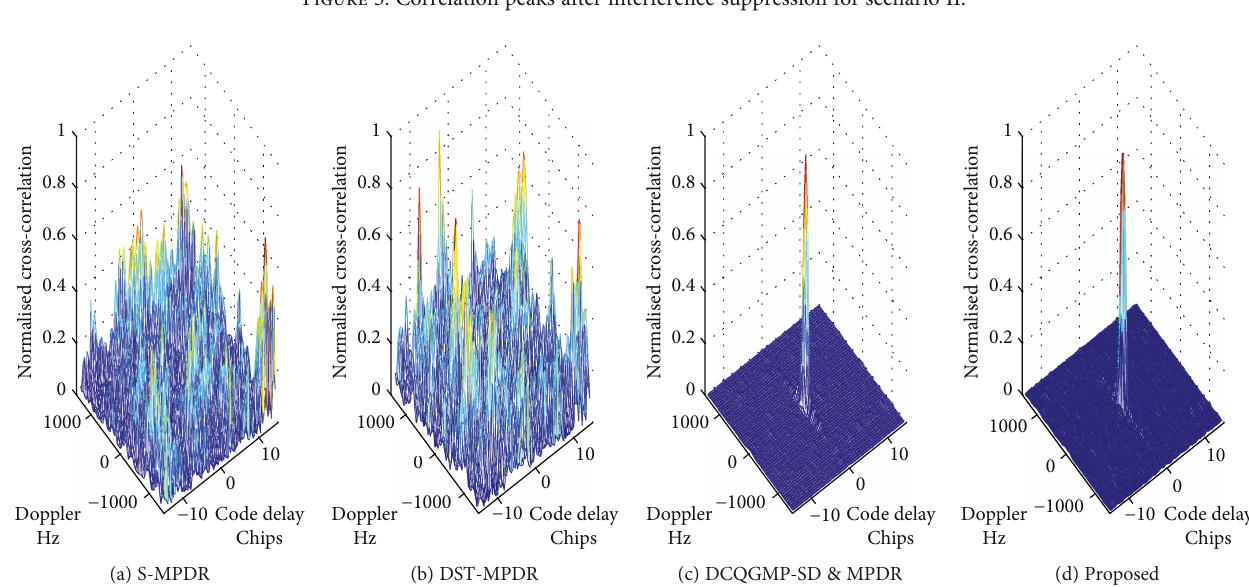
Figure 5: Correlation peaks after interference suppression for scenario II .